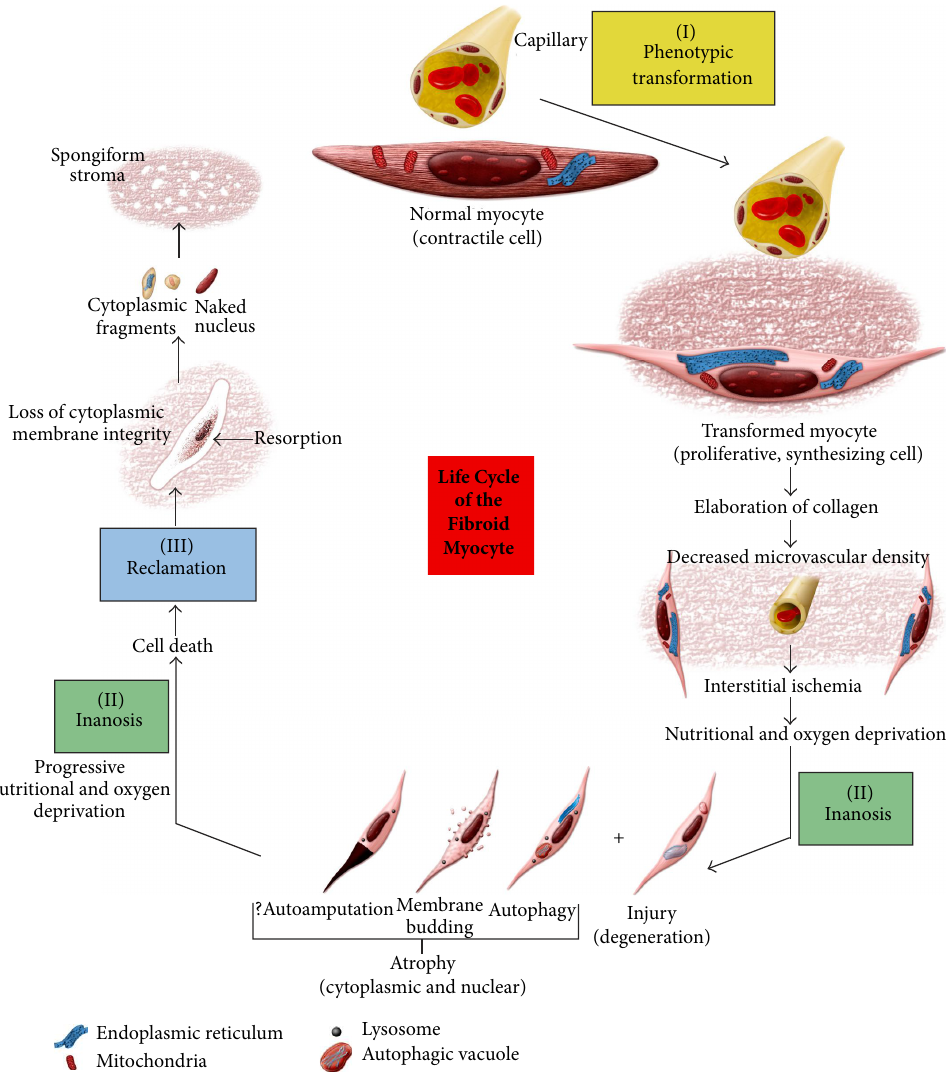
Figure 20: Life cycle of the fibroid myocyte. In this graphic representation, we have attempted to summarize our impression of the fibroid myocyte life cycle, from (I) phenotypic transformation to a proliferating, synthesizing cell, to (II) inanotic injury, atrophy, and ultimately cell death resulting from interstitial and vascular ischemia, to (III) reclamation in which dead cells and cell contents are resorbed by enzymatic degradation without the involvement of phagocytic cells. Illustration by David Sabio, Experimental Pathology